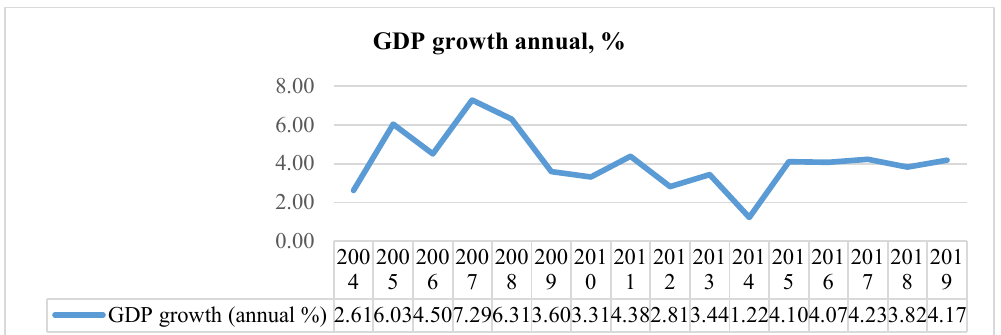
Fig. 1. Real GDP growth in Kosovo (2004–2019). Source: World Bank Indicators, GDP growth for Kosovo, time period 2004–2019, the authors’ calculations.